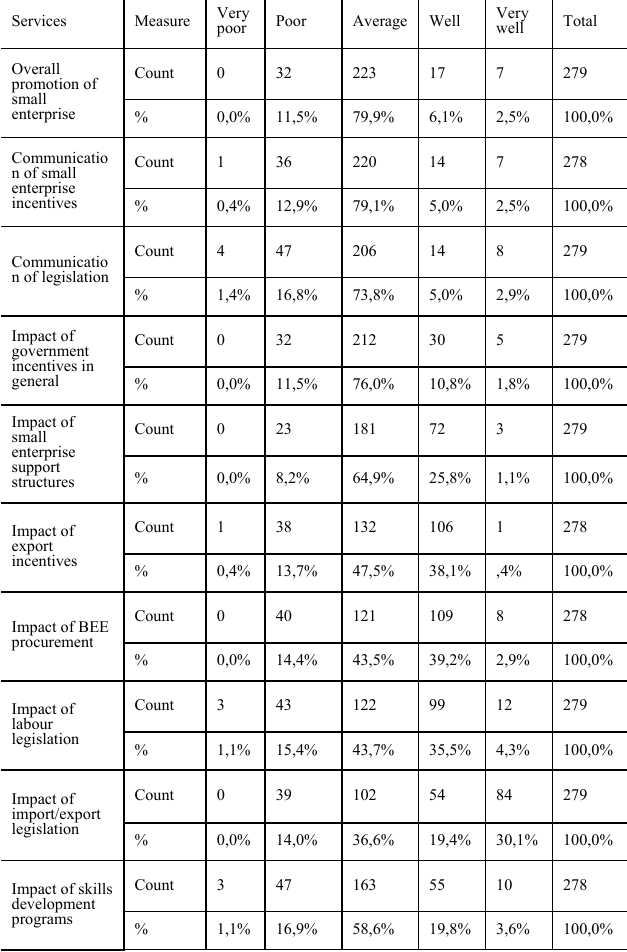
Table 9: Rating of government initiatives Table 10: Obstacles to achieving your business goals